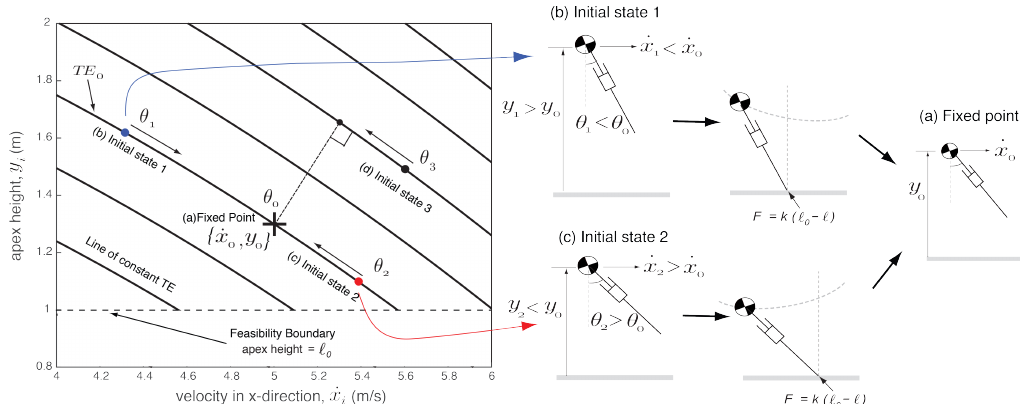
Figure 2. Control of foot placement angle. The plot shows the velocity in the x -direction ( ˙ x i ) versus the vertical height ( y i ) at the Poincaré section, which is at the apex in the flight phase. (a) The fixed point is { ˙ x 0 , y 0 } = { 5,1.3 } , which corresponds to the foot placement angle θ 0 = 0.3465 rad. (b) Initial states such as { ˙ x 1 , y 1 } need to decrease the foot placement angle θ 1 to converge to the limit cycle. (c) Initial states such as { ˙ x 2 , y 2 } need to increase the foot placement angle θ 2 to converge to the limit cycle. (d) Initial conditions such as { ˙ x 3 , y 3 } which are not on the TE 0 line cannot converge to the fixed point { ˙ x 0 , y 0 } because there is no means to change the total energy of the system (drawing not